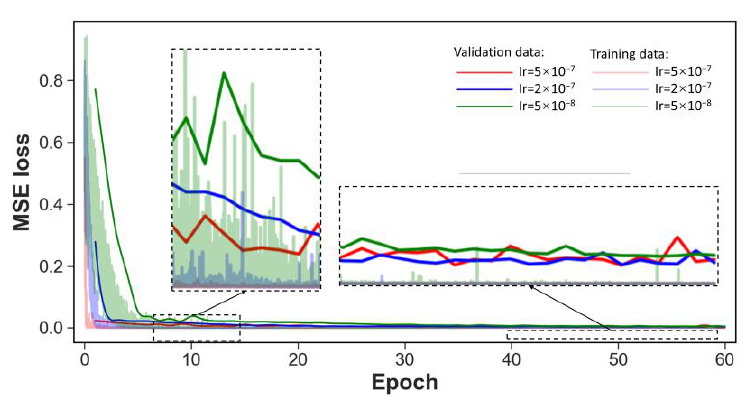
Figure 10. Accuracy evolution of temperature field on training and validation dataset with various learning rates.